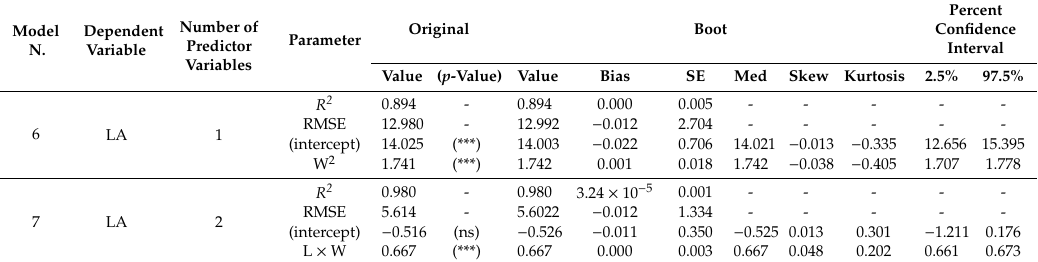
Table 5. Main outputs for non-parametric bootstrap analysis (replications: 1000) of models 6 and 7 fitted with data from the loquat single leaf area (LA in cm 2 ) from leaf length (L) and width (W) measurements. Standard errors and p -value in parenthesis; L and W were in cm. Model N.